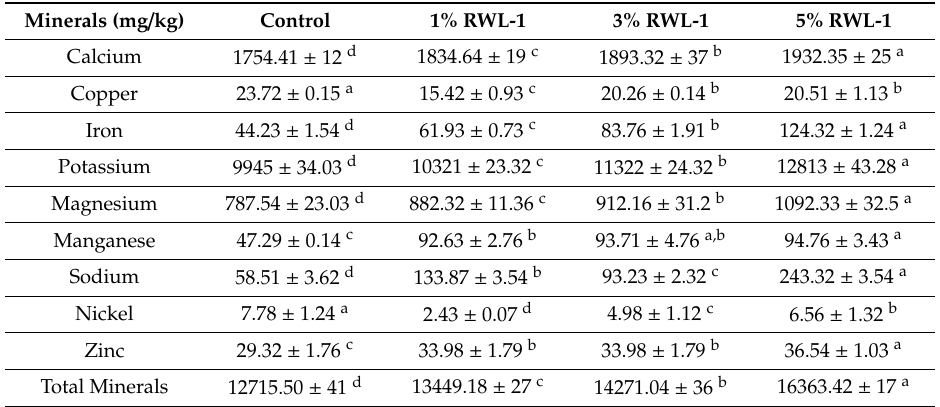
Table 3. Minerals analysis in non-fermented and fermented soybean with various concentrations (1%, 3%, and 5%) of B. amyloliquefaciens